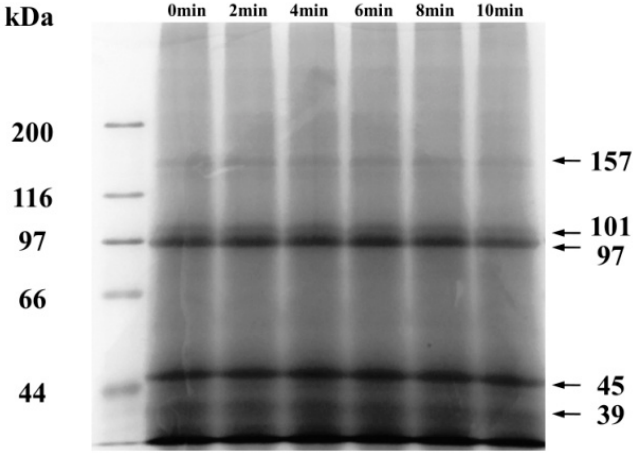
Figure 1. Reducing sodium dodecyl sulfate-polyacrylamide gel electrophoresis (SDS-PAGE) of ball-milled scallops ( Chlamys farreri ) protein (CFP) (0, 2, 4, 6, 8, and 10 min). The molecular weights of protein marker were 200 kDa, 116 kDa, 97 kDa, 66 kDa, and 44 kDa.